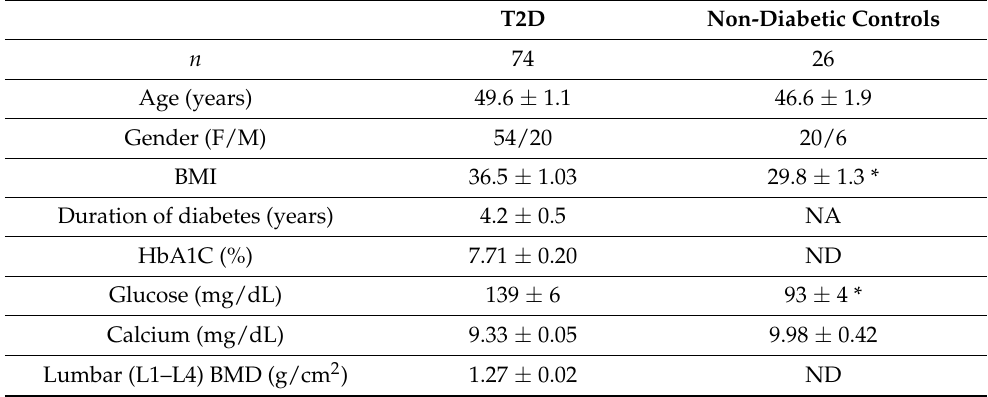
Table 1. Ages, BMI, duration of diabetes, BMD, and various blood biomarkers in subjects with diabetes (T2D) and non-diabetic control subjects. Values (mean SE) marked * are significantly different ( p < 0.05). ND, not